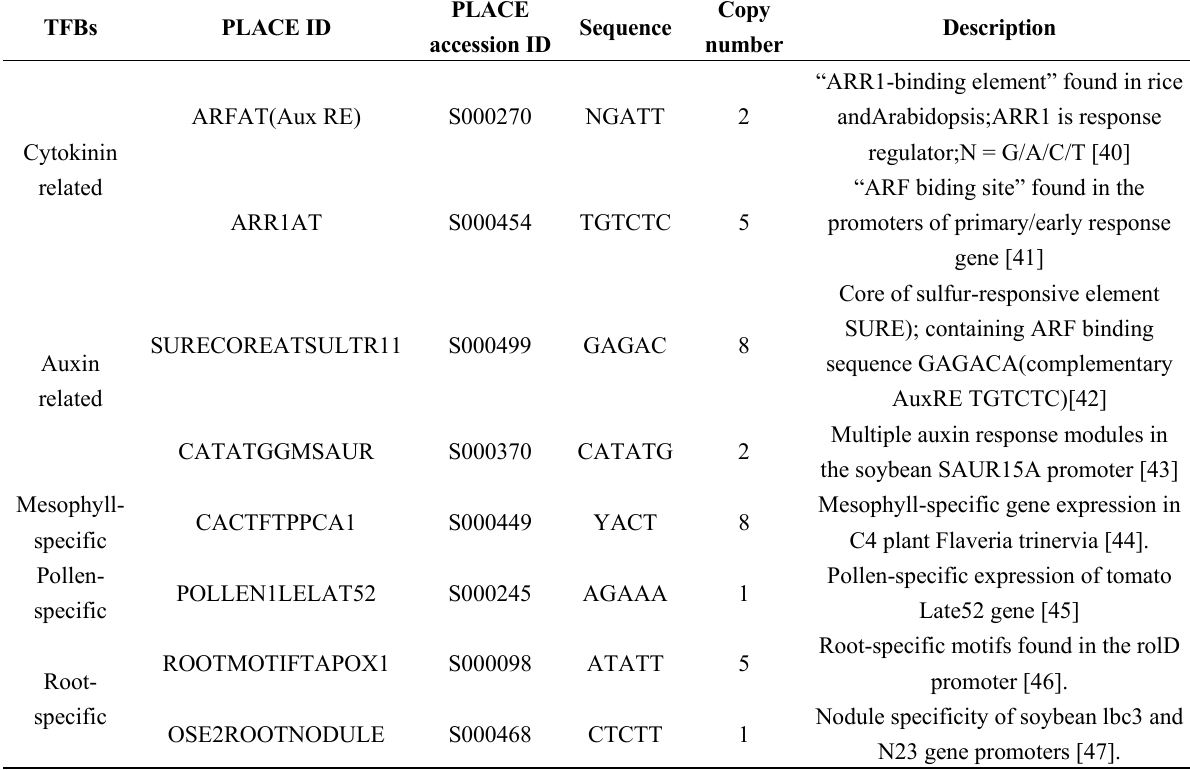
Table 2. The putative transcriptional factor binding sites (TFBs) identified from the PLACE